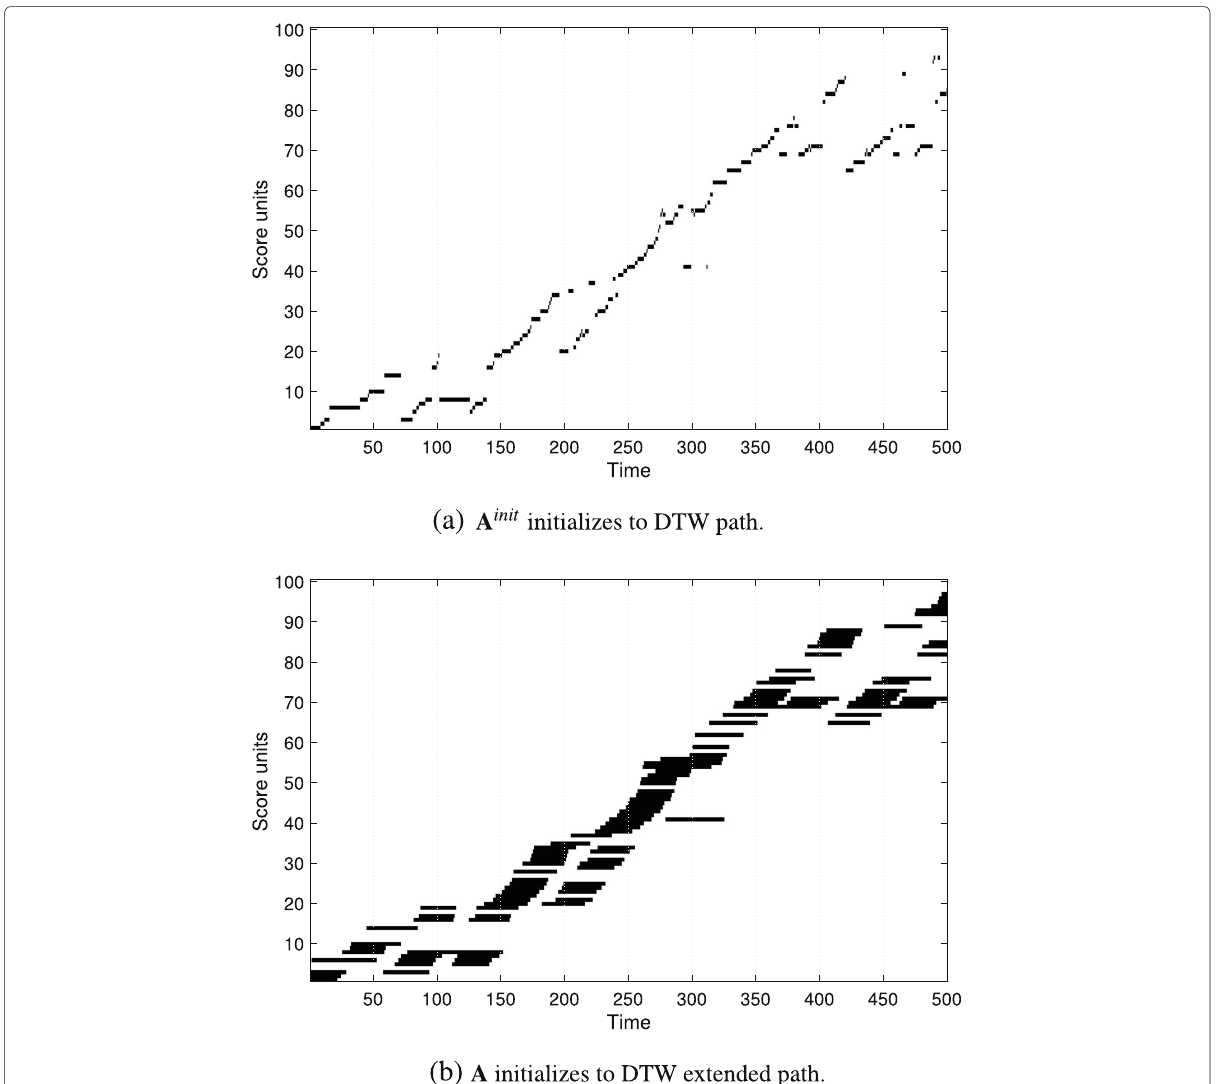
Fig. 4 A initialization for a music signal from the test database in Section 5.1 (A. Bruckner’s Symphony no. 8, II movement, bars 1-61). a Aligned piano-roll. b Extended aligned